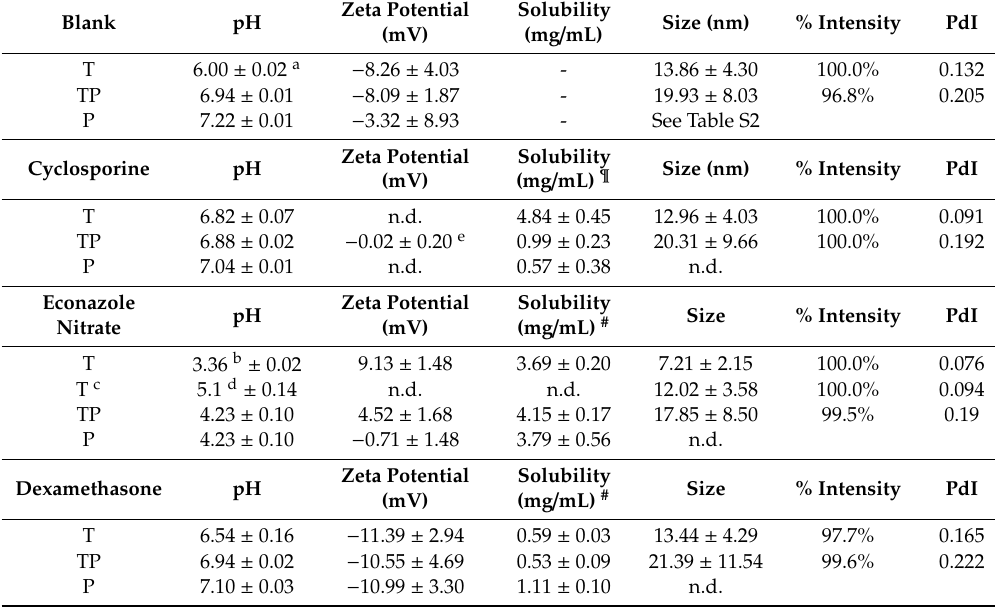
Table 4. Characteristics of blank and drug-loaded micelles. Micelle size reported is from DLS analysis; (n.d. = not